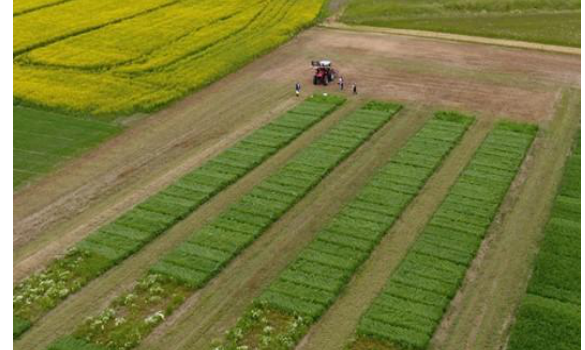
Figure 8 Photograph of the Boreal Plant Breeding Ltd. grass variety testing field in Jokioinen on 24.7.2017.